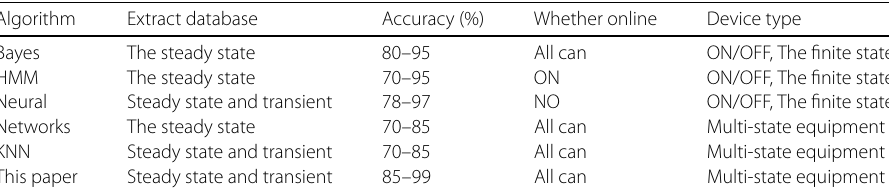
Table 8 Comparison with some reference algorithms